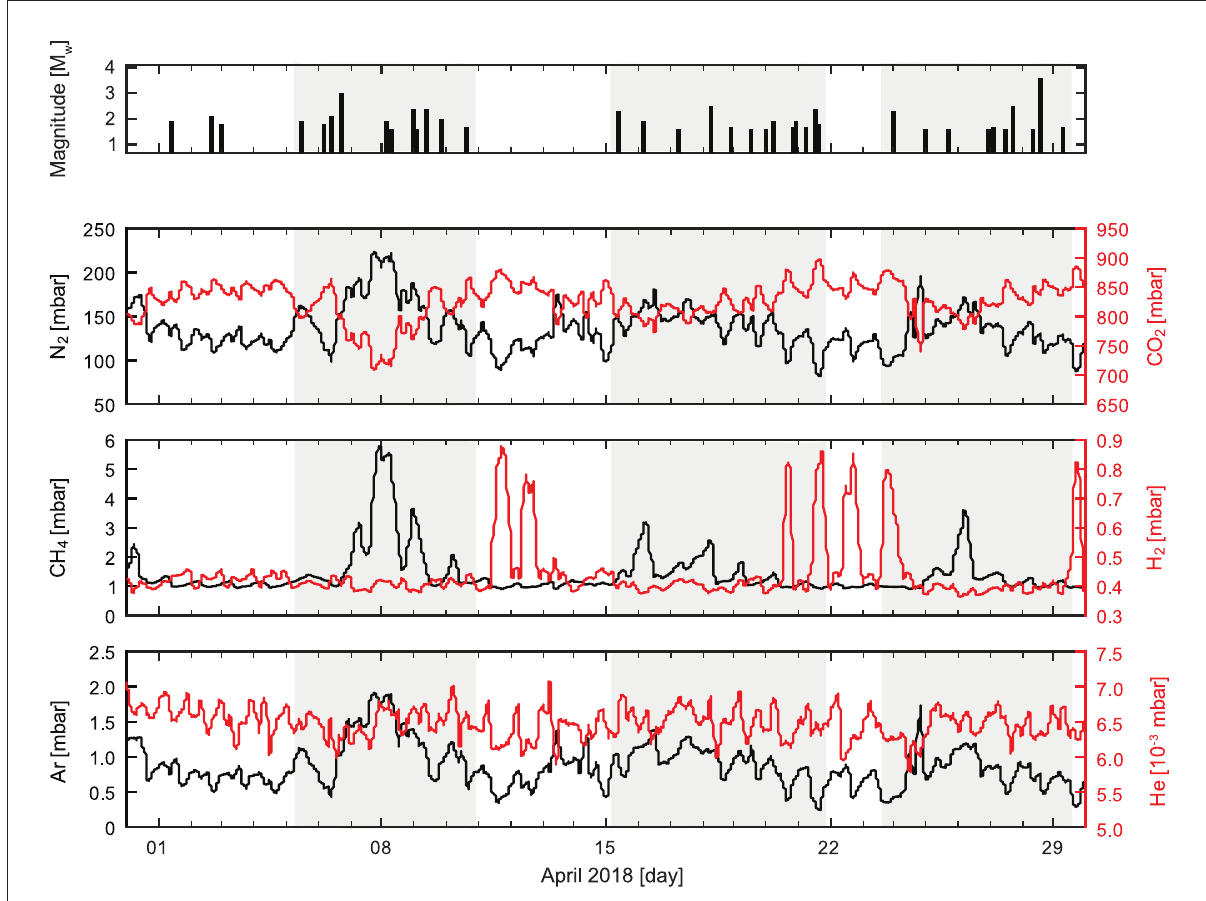
FIGURE4 Time series of gas measurements ( > 2,000 data points) conducted in April 2018 at the hydrothermal well in Beppu (Japan). The (upper panel) indicates phases of low (white background) and of higher (gray background) seismic activity. The (lower panels) show the long-term temporal variation of the measured gas species. The main (carrier) gases are anti-correlated (CO 2 and N 2 ). High concentrations of CH 4 correlate with high concentrations of N 2 , while high concentrations of H 2 correlate with high concentrations of CO 2 . Mid-term changes as seen for N 2 and CH 4 can also be observed in the Ar time series. He does not seem to be affected by low or higher seismic activities. As for Figure 3, a Savitzky-Golay filtering (frame length 27 and order 3) was used to smooth the